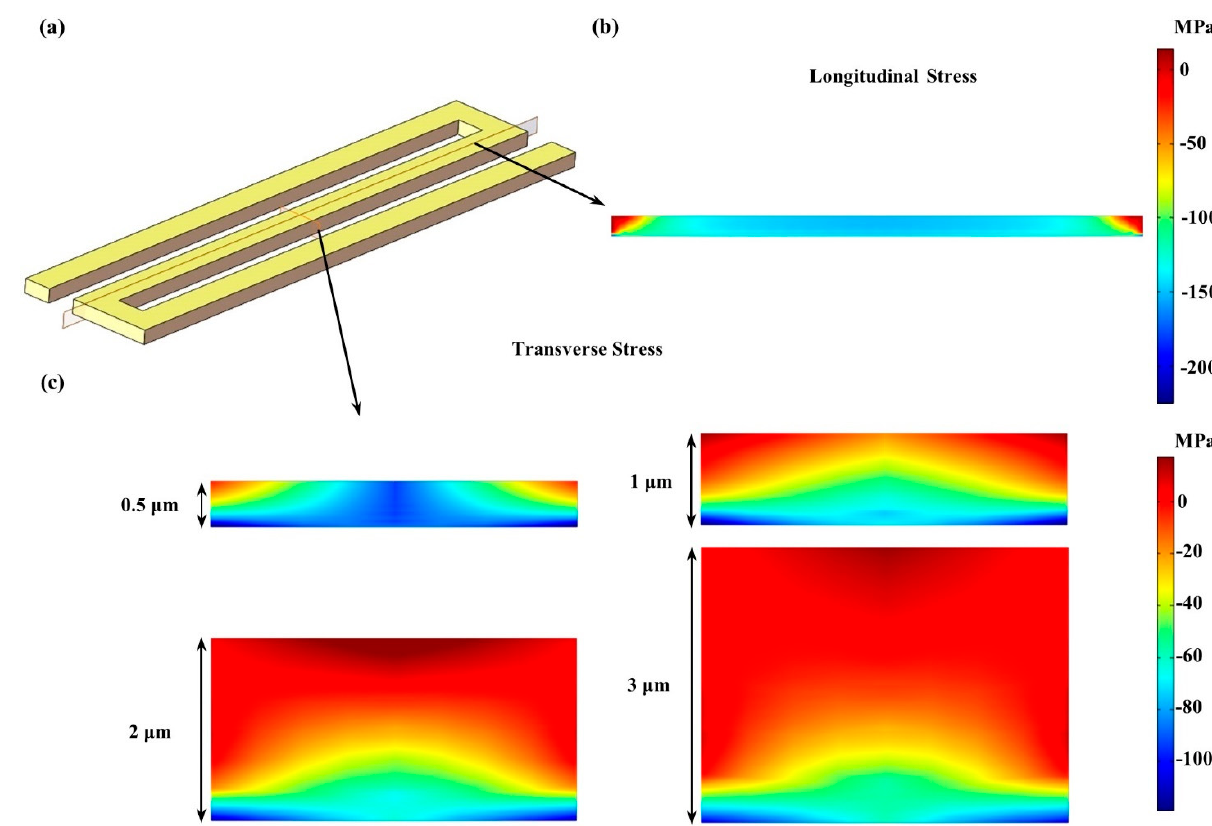
Figure 4. Numerical simulation of the inside stresses of the developed piezoresistive pressure sensor: ( a ) the piezoresistor model at the center of the diaphragm with two cross sections in different directions; ( b ) the longitudinal stress on the longitudinal section when the thickness of piezoresistor was 3 μ m; ( c ) the transverse stress on the transverse section when the thickness of piezoresistor varies from 0.5 to 3 μ m.